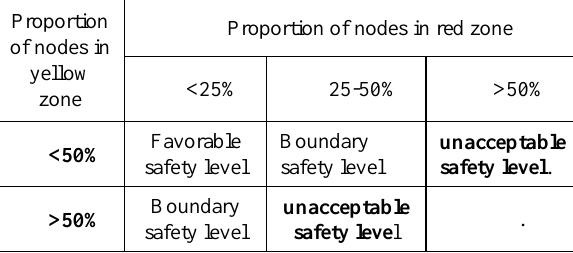
Table 1. Unfailing performance and stability matrix Proportion